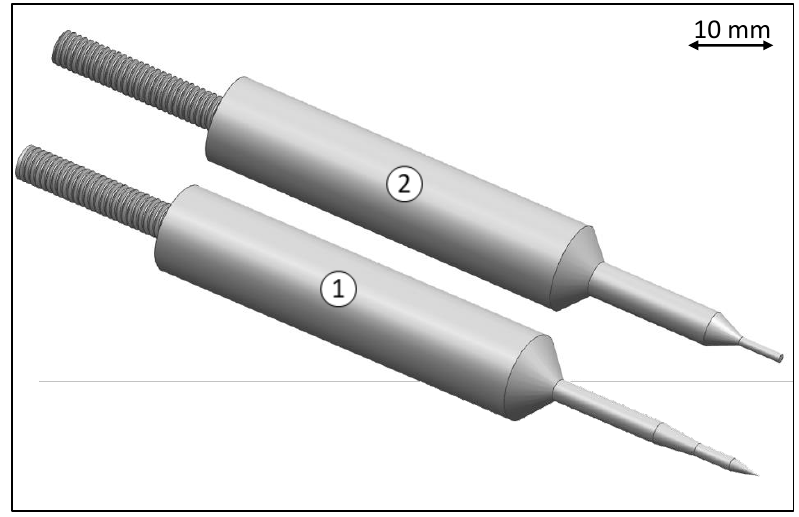
Figure 3. Image of the two measuring tips of the tactile